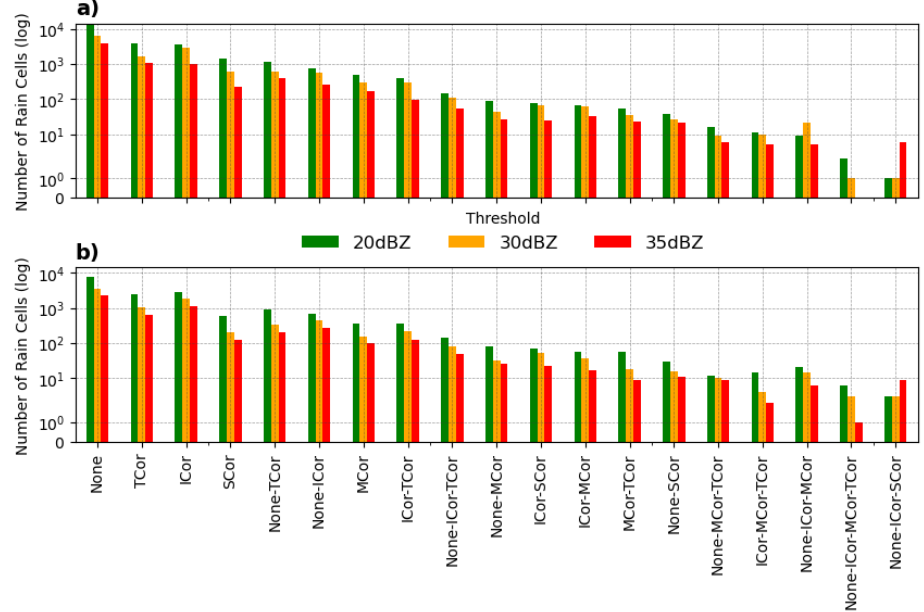
Figure 11. Number of rain cells (clusters) corrected with combined methods using adaptive mode. Distributed in descending order for IOP1 ( a ) and IOP2 ( b ).